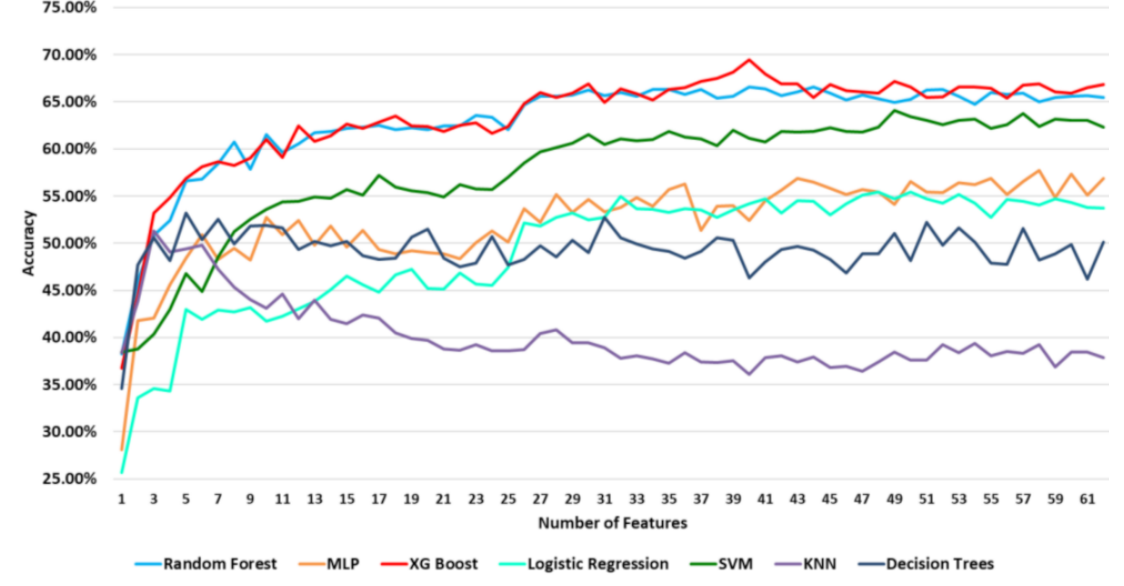
Figure 6. Classification results. Table 11. The maximum accuracy achieved from the classification models. The best performance is shown in bold.